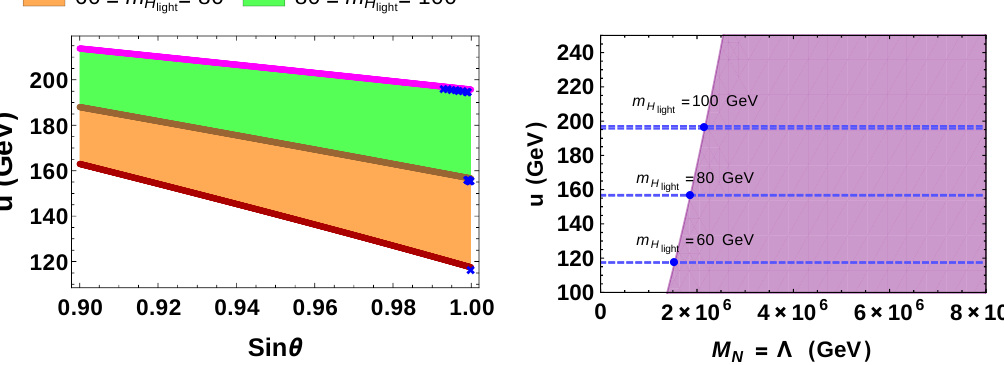
Figure 13 . Left panel: u (= M (cid:31) =y ) vs sin (cid:18) plot for (cid:21) 1 = (cid:21) 2 = (cid:21) for various range of m H Here the magenta, brown and dark red dots represent allowed points obtained (from (cid:12)gure 5) relic density for m H = 100, 80 and 60 GeV. Blue dots on each line are the points allowed by the light direct search limit. Right panel: u (= M (cid:31) =y ) as a function of (cid:3) (or M N ) considering M N = (cid:3) in eq. (5.1) and (5.2). Purple shaded region represents m (cid:23) (cid:20) 0 : 23 eV with M N = (cid:3) and the horizontal blue patches represent the allowed region of u (= M (cid:31) =y ) obtained the left panel for the speci(cid:12)c light Higgs masses. This imposes a stringent constraint on the lower limit of the cut-o(cid:11) scale (cid:3) (and RH neutrino mass M N